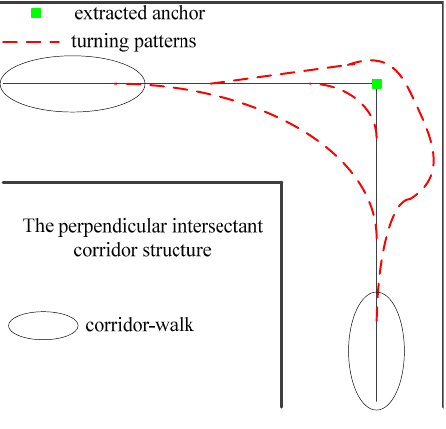
Figure 4. An example of anchor extraction from corridor-walks.